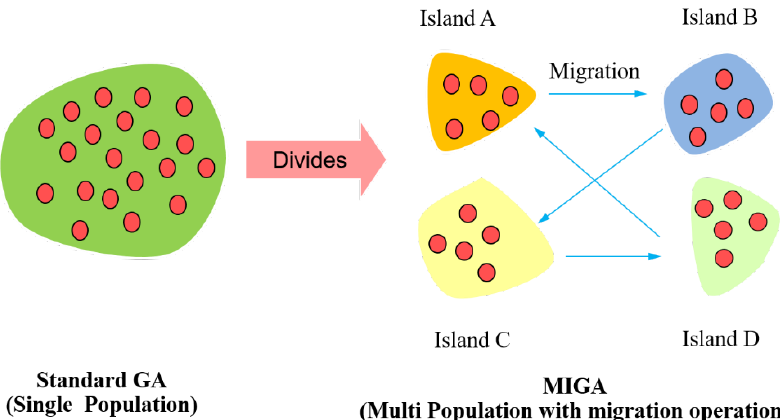
Figure 3. Subpopulation/Island generation principle in MIGA [32].